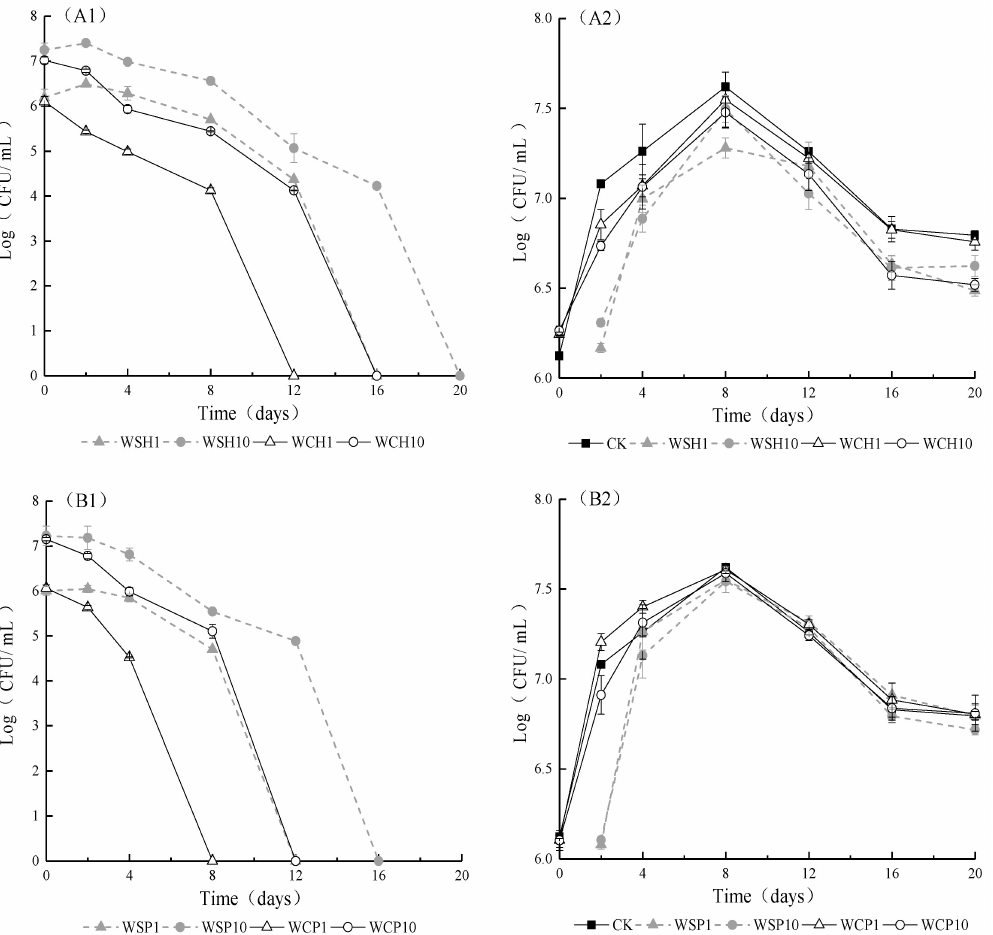
Figure 2. Growth status of Saccharomyces cerevisiae and NS yeasts in different fermentation systems: ( A ) inoculation of Hanseniaspora uvarum , ( B ) inoculation of Pichia fermentans. The 1 stands for NS, and 2 stands for Saccharomyces cerevisiae .